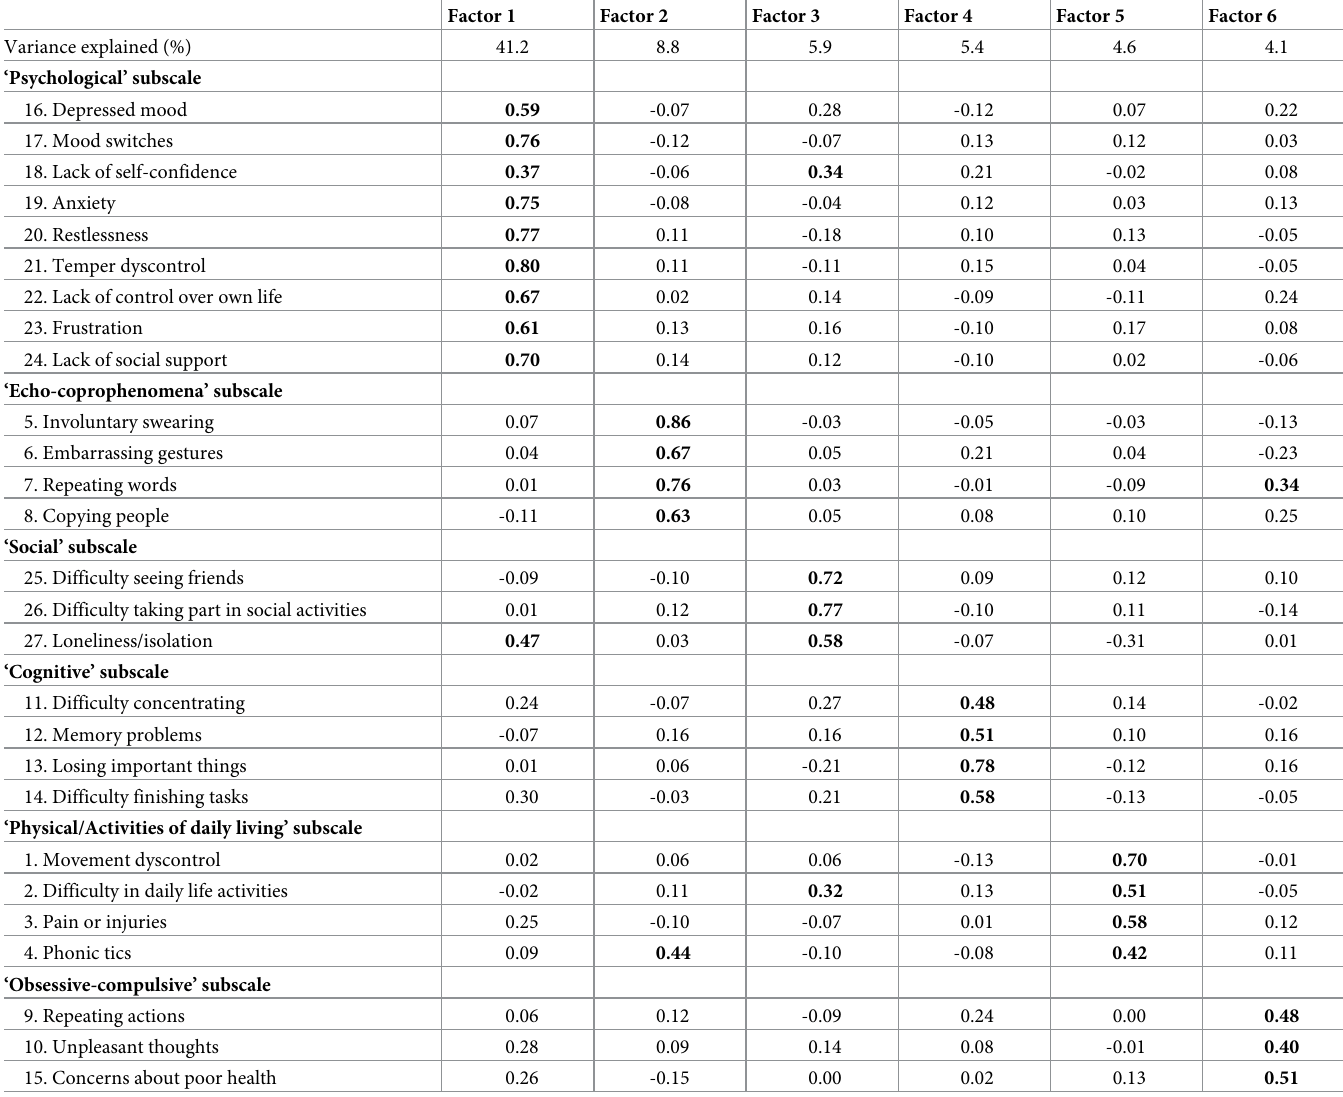
Table 3. Factor loadings from the factor analysis of the GTS-QOL-French